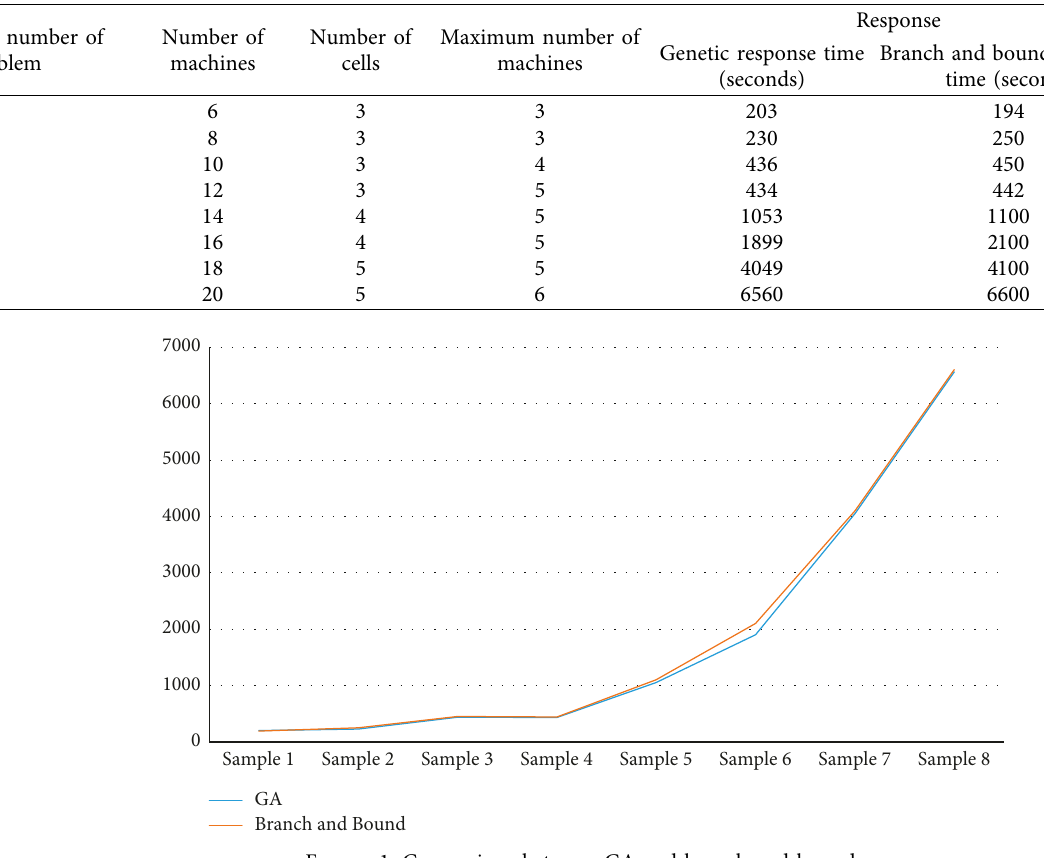
Figure 1: Comparison between GA and branch and